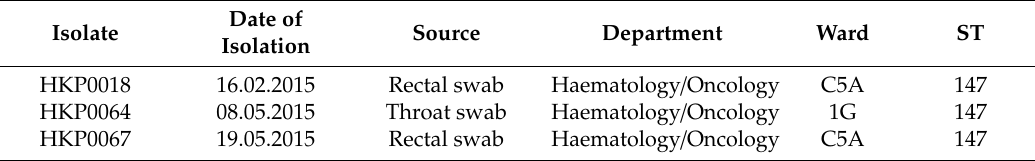
Table 3. K. pneumoniae clinical isolates